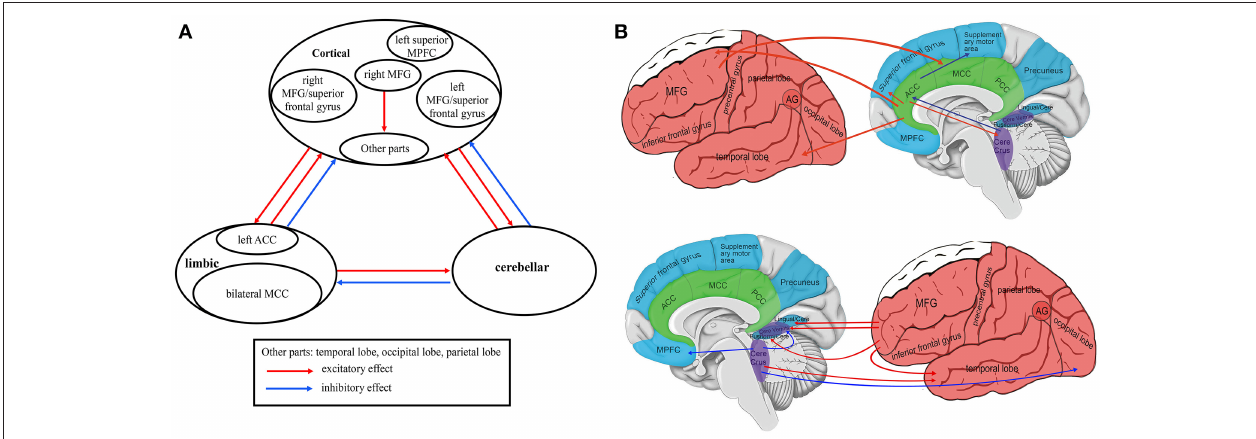
FIGURE 3 | Integrated model of voxel-wise Granger causality analyses in first-episode, drug-naive somatization disorder (Seed-to-Whole-Brain Analyses): affected causal connectivities in the cortico-limbic-cerebellar circuit (A) . Brain regions and circuitry implicated in first-episode, drug naive somatization disorder (Seed-to-Whole-Brain Analyses) (B) . MFG, Middle Frontal gyrus; MPFC, Medial Prefrontal Cortex; ACC, Anterior Cingulate Cortex; MCC, Middle Cingulate Cortex; PCC, Posterior Cingulate Cortex; AG, Angular Gyrus; Cere Crus, Cerebellum Crus; Cere Vermis, Cerebellum Vermis; Lingual/Cere, Lingual Gyrus/Cerebellum Vermis; Fusiform/Cere, Fusiform Gyrus/Cerebellum. Lateral cortical regions are shown in red, medial cortical regions in blue, subcortical regions in green, and cerebellum regions in purple. The functional pathways in (A,B) are indicated with red arrows (excitatory effect) and blue arrows (inhibitory effect).